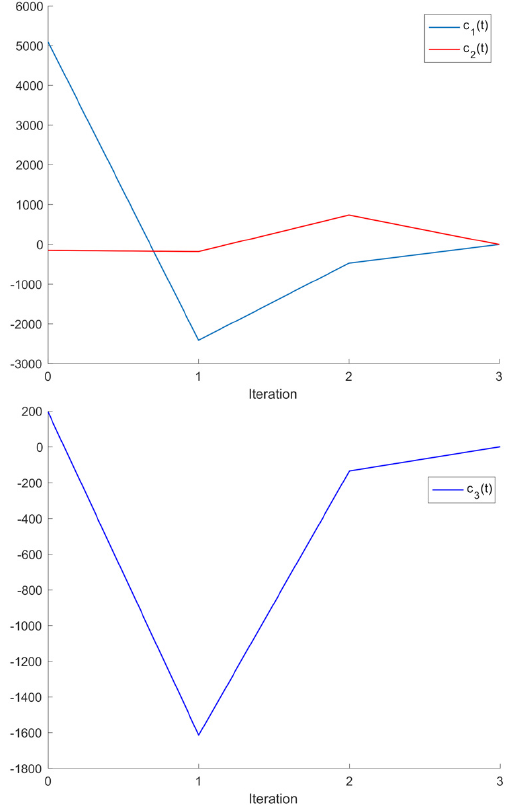
Figure 2. Demands vector components in Example